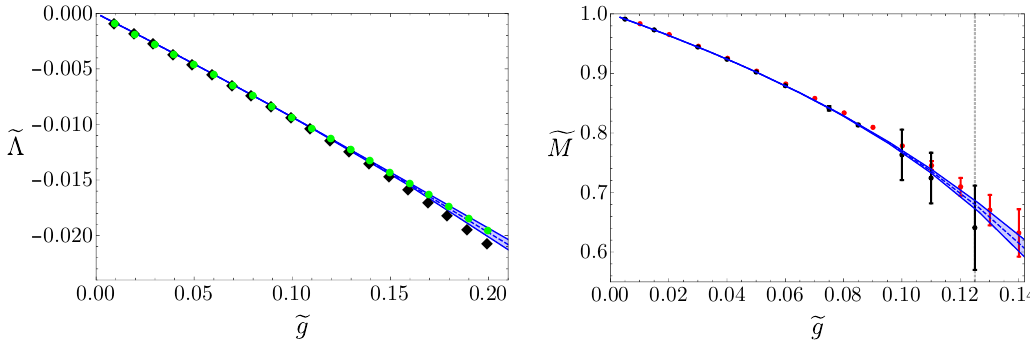
Figure 10 . Left panel: comparison with ref. [10] of the vacuum energy as a function of blue dashed line are our results obtained by Borel resummation with conformal mapping, black and green points are the results of ref. [10] at (cid:12)nite volume L = 12 and L = 20, respectively. Right panel: comparison with refs. [10, 11] of the physical mass as a function of are our results obtained by Borel resummation with conformal mapping, the black points are the results of ref. [11] extrapolated at in(cid:12)nite volume, the red points are the results of ref. [10] at (cid:12)nite volume L = 20. The vertical dotted line at where the mass of the elementary particle is twice the mass of the kink and might become